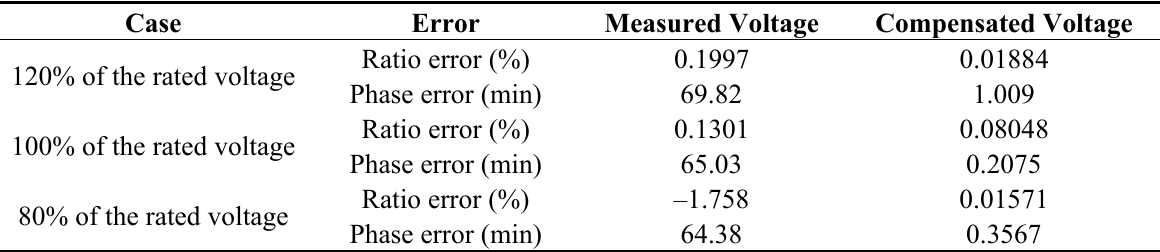
Table 5. Results for the experimental